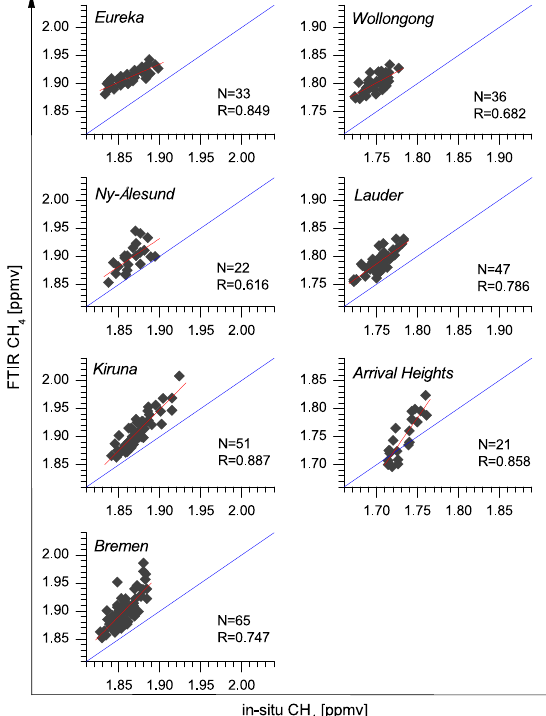
Figure 11. As Fig. 8 but for the rest of the stations and for co- incident data within ± 15 days. The corresponding station name is shown in each